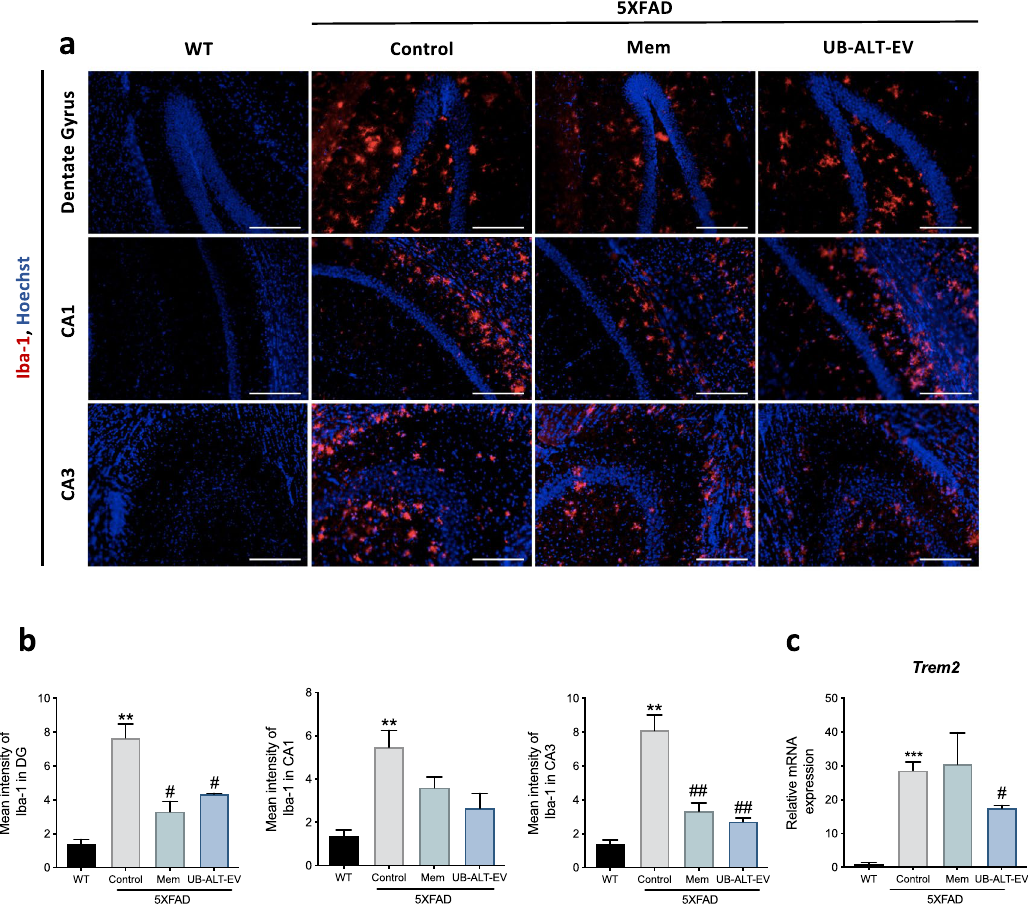
Figure 2. Treatment-induced changes in the expression of microglial activation markers with NMDA receptor antagonists in 5XFAD of 6 months of age. Representative Iba-1 (Red) and Hoechst (Blue) positive staining in dentate gyrus, CA1 and CA3 hippocampal areas ( a ). Scale bars: 200 μm. Mean intensity of Iba-1 staining in dentate gyrus, CA1 region, and CA3 region ( b ). Representative gene expression for Trem2 ( c ) . Values